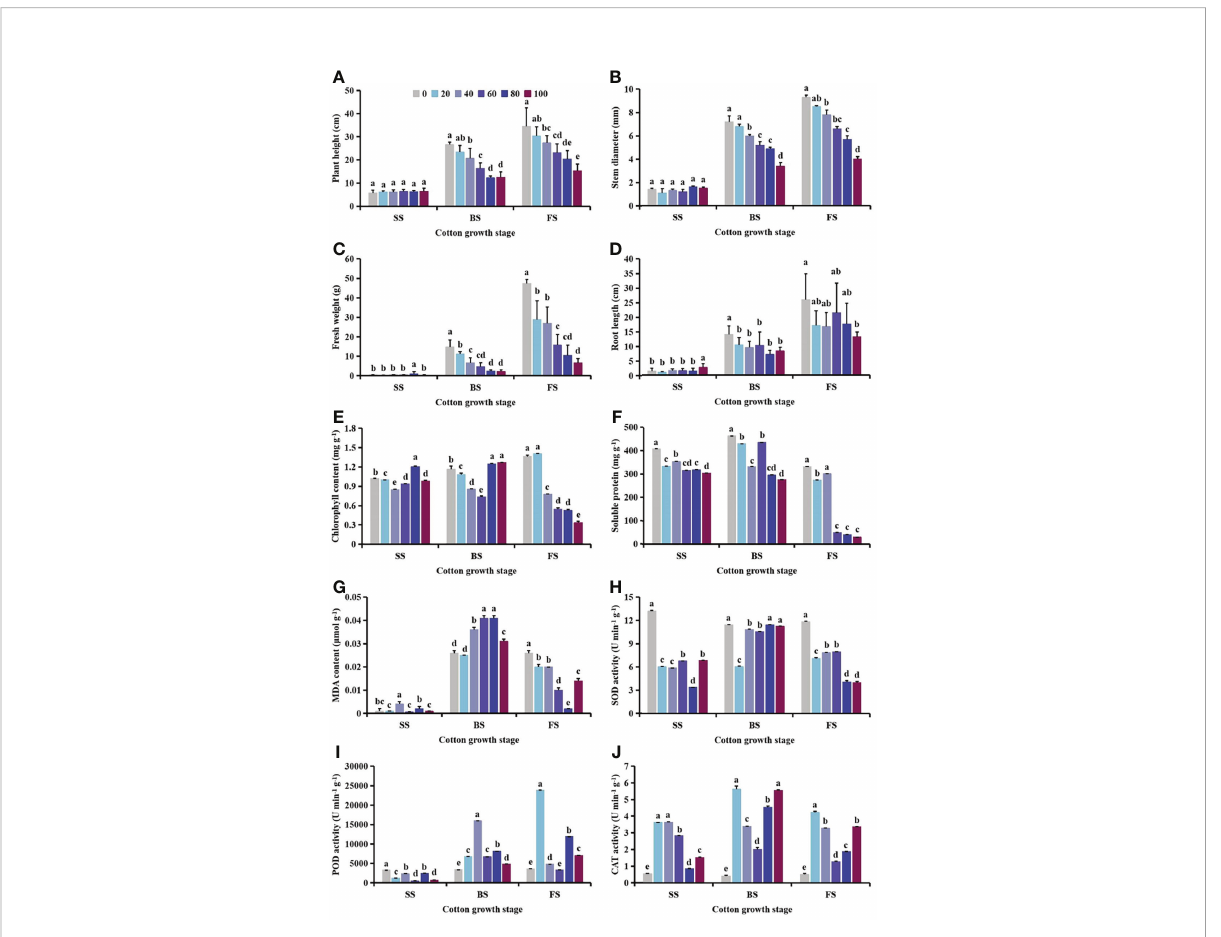
FIGURE 2 Under seedling, budding, and fl owering and boll stages of cotton, the (A) plant height, (B) stem diameter, (C) fresh weight, (D) root length, (E) chlorophyll, (F) soluble protein (G) and malondialdehyde (MDA) content, and (H) superoxide dismutase (SOD). (I) peroxidase (POD) and (J) catalase (CAT) activities of cotton at different Scirpus planiculmis densities. SS, seedling stage, BS, budding stage, FS, fl owering and boll stage. Results are mean ± standard error ( p <0.05). The mean value ± standard data were presented in the fi gure. Different alphabetical letters indicate the signi fi cant differences between different S. planiculmis density ( p